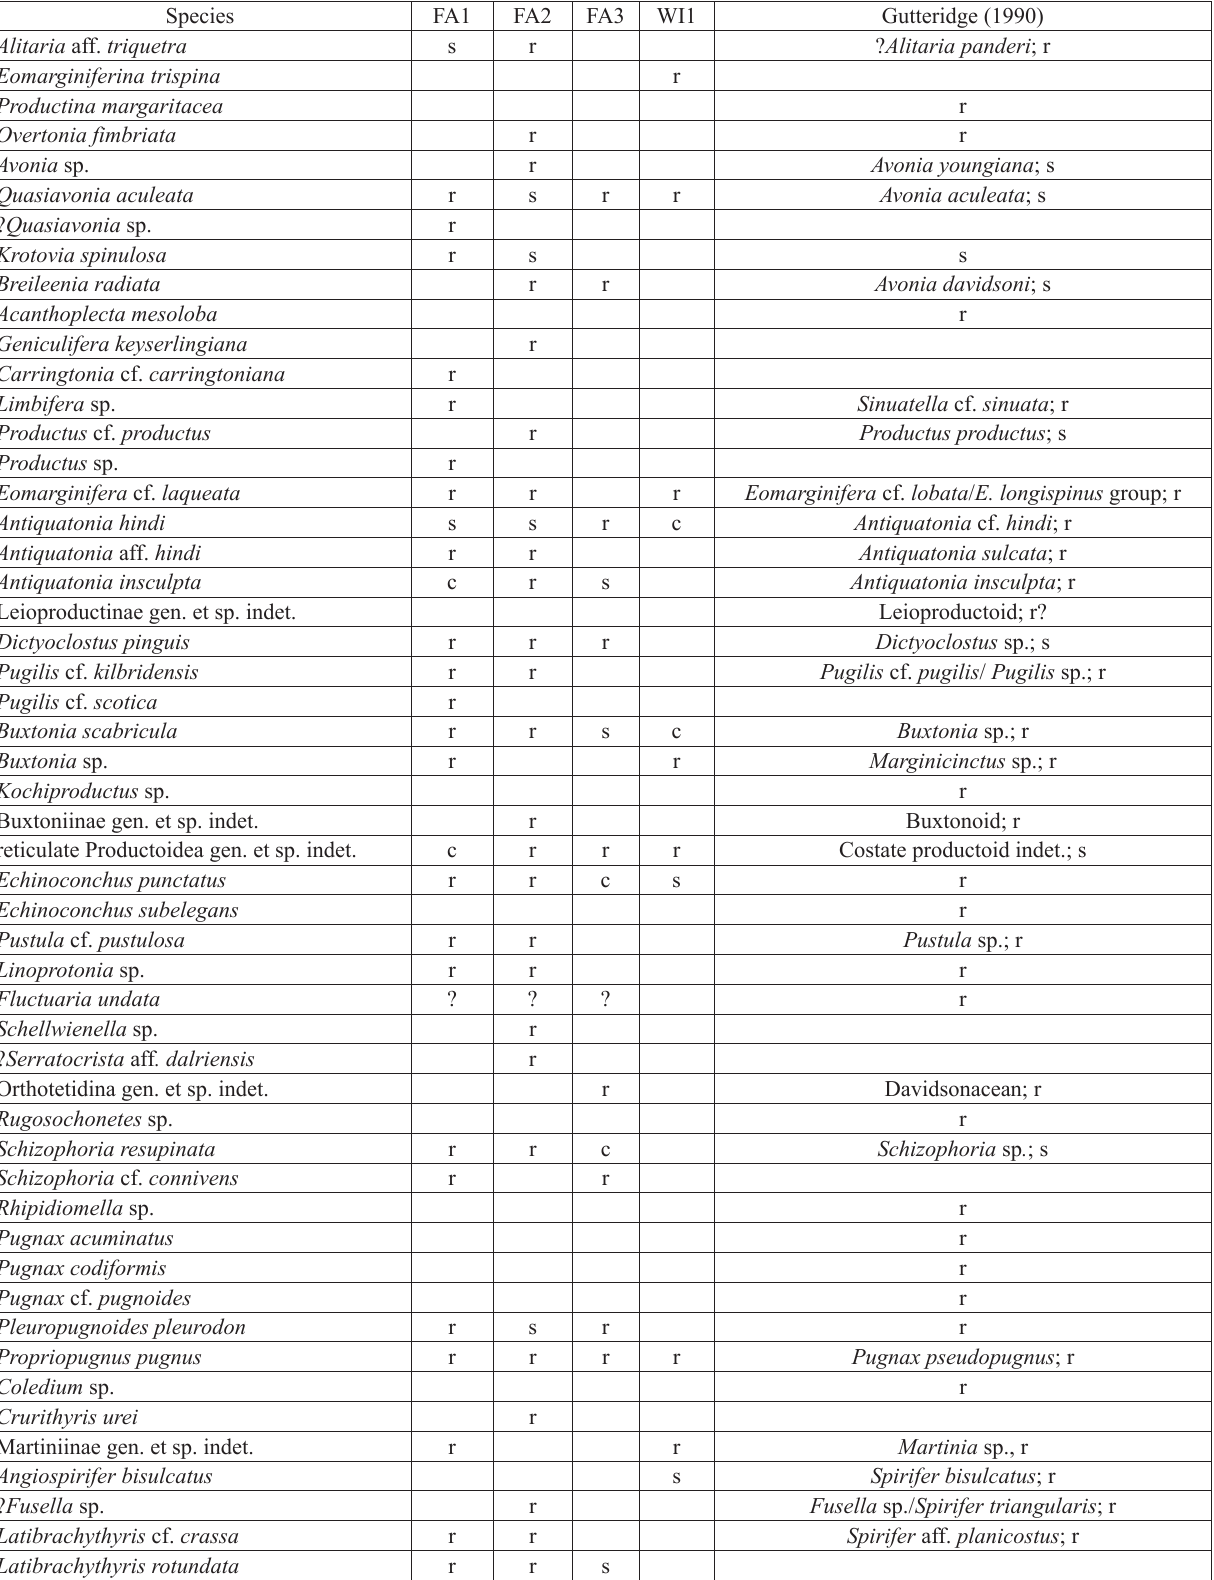
Table 2. Range chart of the brachiopod fauna in the Ricklow mound complex (FA1, FA2, FA3). The table also shows the faunal composition of the fauna collected from Wensley Dale (WI1) and the one collected by Gutteridge (1990) in the Ricklow mound complex core, with synonymy and inferred abundance. Rare (r) <5%; sparse (s) 5–10%; common (c) 10–25%; abundant (a) >25%; ?, unkown location in the mound